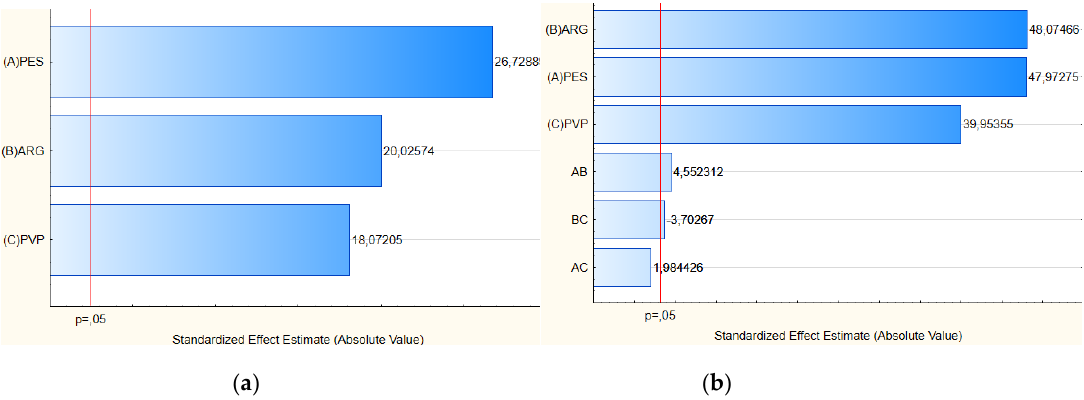
Figure 7. Pareto chart for the models obtained by the mixed design for contact angle: ( a ) linear and ( b ) quadratic.